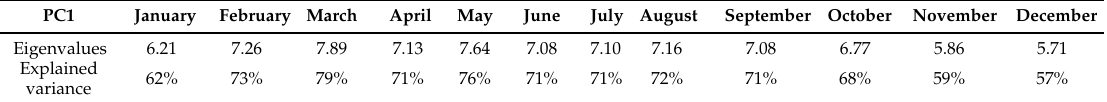
Table 1. Eigenvalues and explained variance of the PC1.